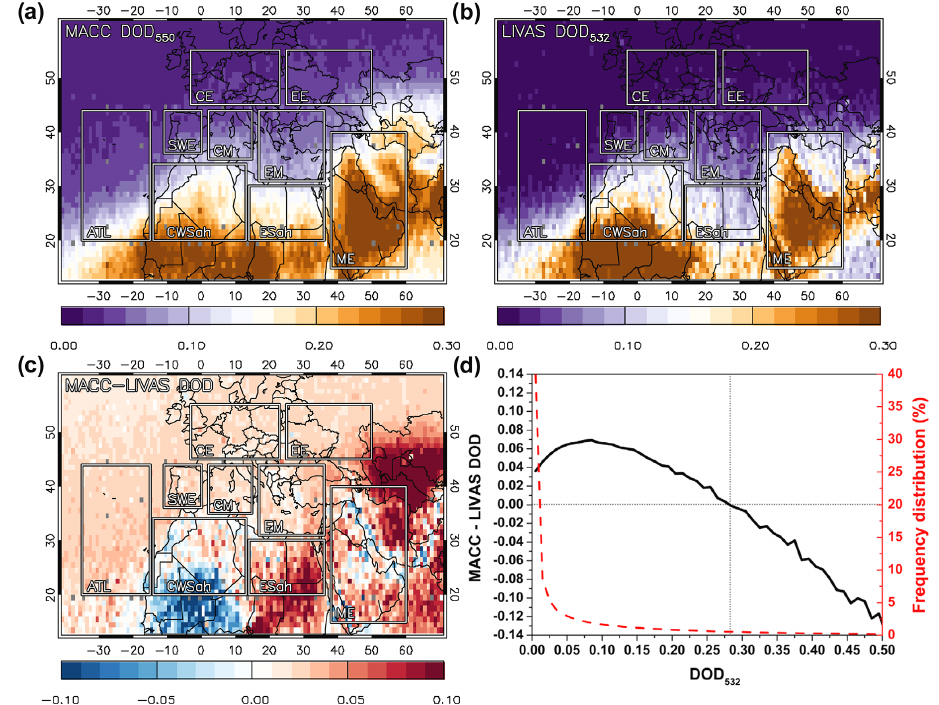
Figure 2. Annual patterns of the MACC DOD 550 (a) , the LIVAS DOD 532 (b) and their mean bias (MB) over the Europe–northern Africa– Middle East (EUNM) domain. The nine subregions used for the generalization of the results are marked on the maps: central Europe (CE), eastern Europe (EE), southwestern Europe (SWE), central Mediterranean (CM), eastern Mediterranean (EM), Atlantic Ocean (ATL), central- western Sahara (CWSah), eastern Sahara (ESah) and Middle East (ME). (d) Plot with the MACC–LIVAS DOD difference relative to the LIVAS DOD 532 (black line) and the frequency distribution (%) of the LIVAS DOD 532 values (red dashed line). It is shown that on average the MACC–LIVAS DOD difference turns negative when the LIVAS DOD 532 exceeds 0.28 while ∼ 90% of the LIVAS DOD 532 values are below this value. All the panels in this and the rest of the figures of the paper refer to the period